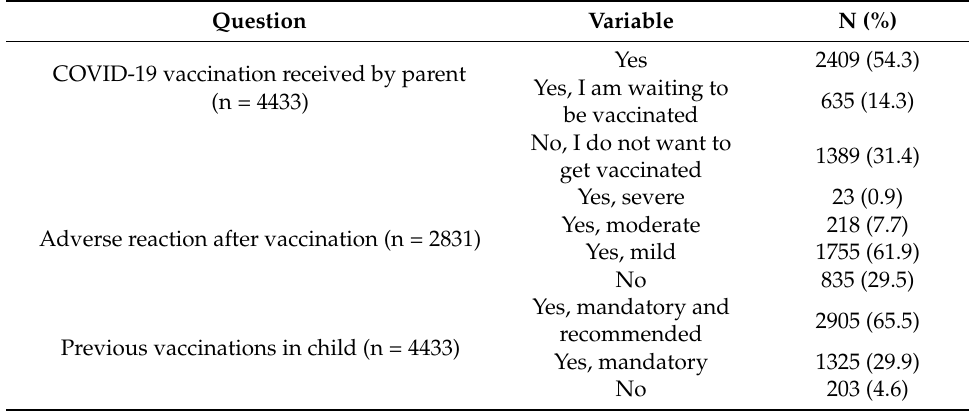
Table 2. Parent’s and child’s history of immunization and assessment of main sources of information on COVID-19